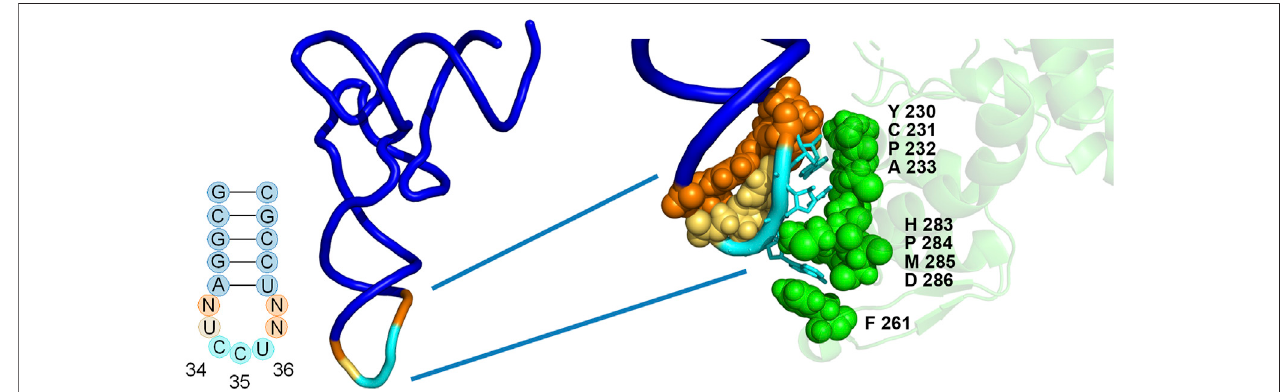
FIGURE2| Positionsoflibrarymutationsmappedontotheco-crystalstructureofthe M.jannaschii tRNA/aaRSpair(PDB1J1U).Positions32,37,and38withinthe tRNA anticodon loop were allowed to vary in conjunction with 9 amino acids in the anticodon binding domain of the aaRS. The diversity available at each position in the aaRS is described both in the text and in Table 1